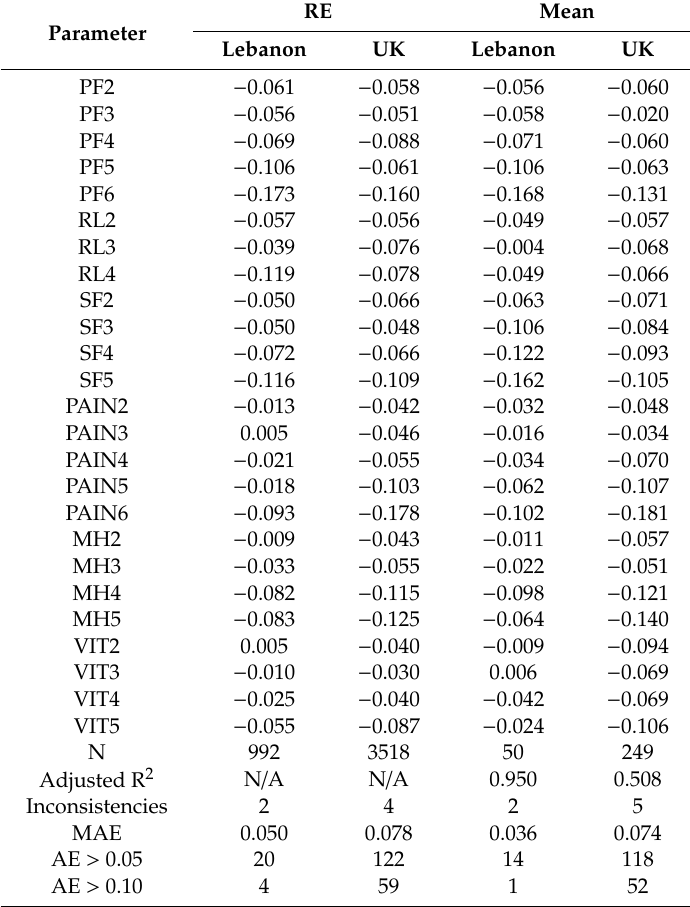
Table 4. Mean and individual level models for Lebanon and